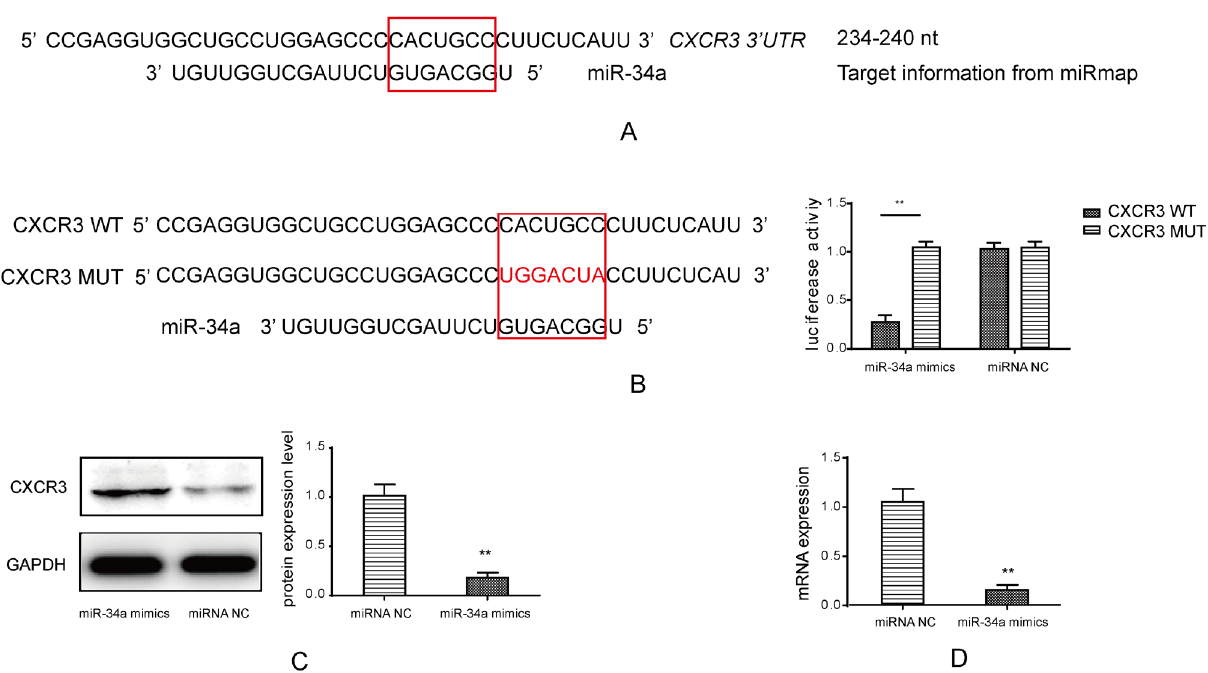
Figure 4 – Target confirmation between CXCR3 and miR-34a. (A) The software miRmap was used to predict the target between CXCR3 and miR- 34a. (B) Luciferase assay was used to identify direct target between CXCR3 and miR-34a, the target sequence was mutated and cloned into luciferase reporter plasmid, the luciferase activity decreased in CXCR3 WT group, **p < 0.01 compared to CXCR3 MUT group. (C) Western blot was used to detect CXCR3 protein level with miR-34a mimics transfection, quantification was calculated based on light density of bands, miR34a mimics reduced protein level compared to miRNA NC, **p < 0.01. (D) Real-time PCR was used to test CXCR3 with miR-34a mimics transfection, miR-34a inhibited mRNA expression of CXCR3 compared to miRNA NC treatment, **p <